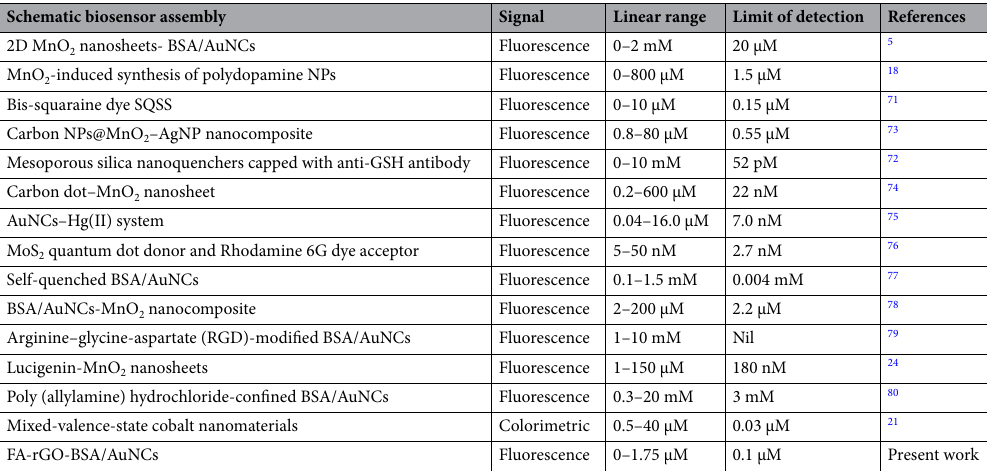
Schematic biosensor